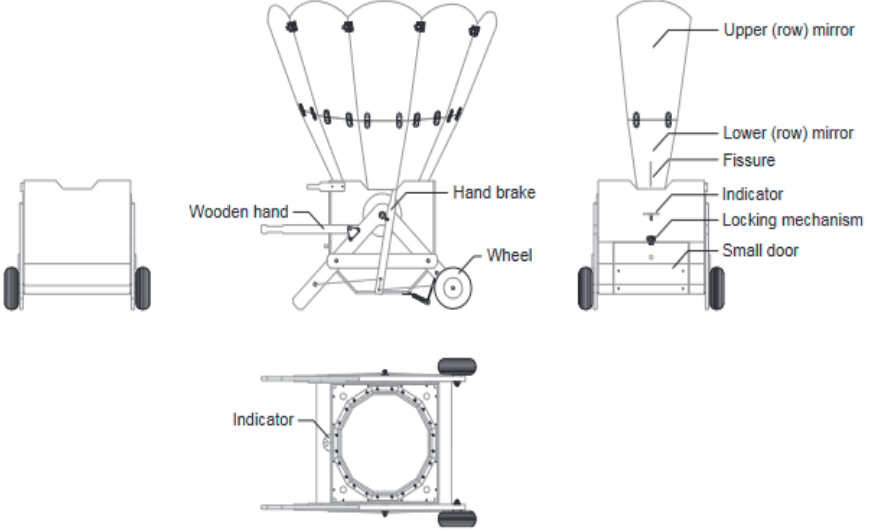
Figure 20. The layout of solar cooker with locking mechanism. Reprinted/adapted with permission from Ref. [63], 2018, Elsevier.